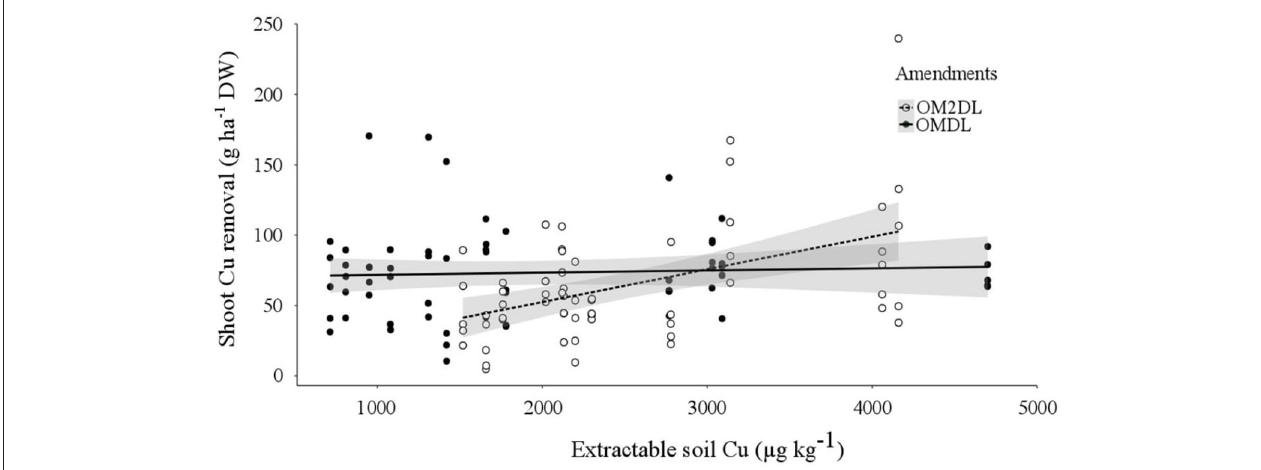
FIGURE 5 | ANCOVA analysis for shoot Cu removal (mg kg − 1 ) of sunflower plants depending on 1M NH 4 NO 3 -extractable soil Cu (mg Cu kg − 1 ) and soil treatments: OMDL (• and black lines) and OM2DL ( ◦ and dotted lines) ( n = 20